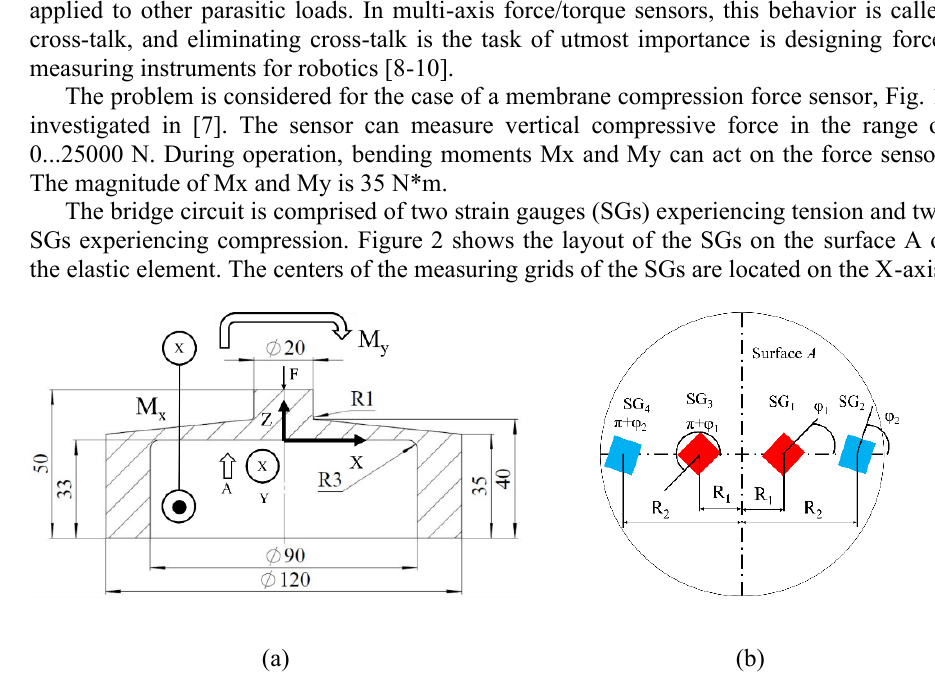
Fig. 2. Elastic element construction (a) and layout of the Wheatstone bridge (b); dimensions are shown in